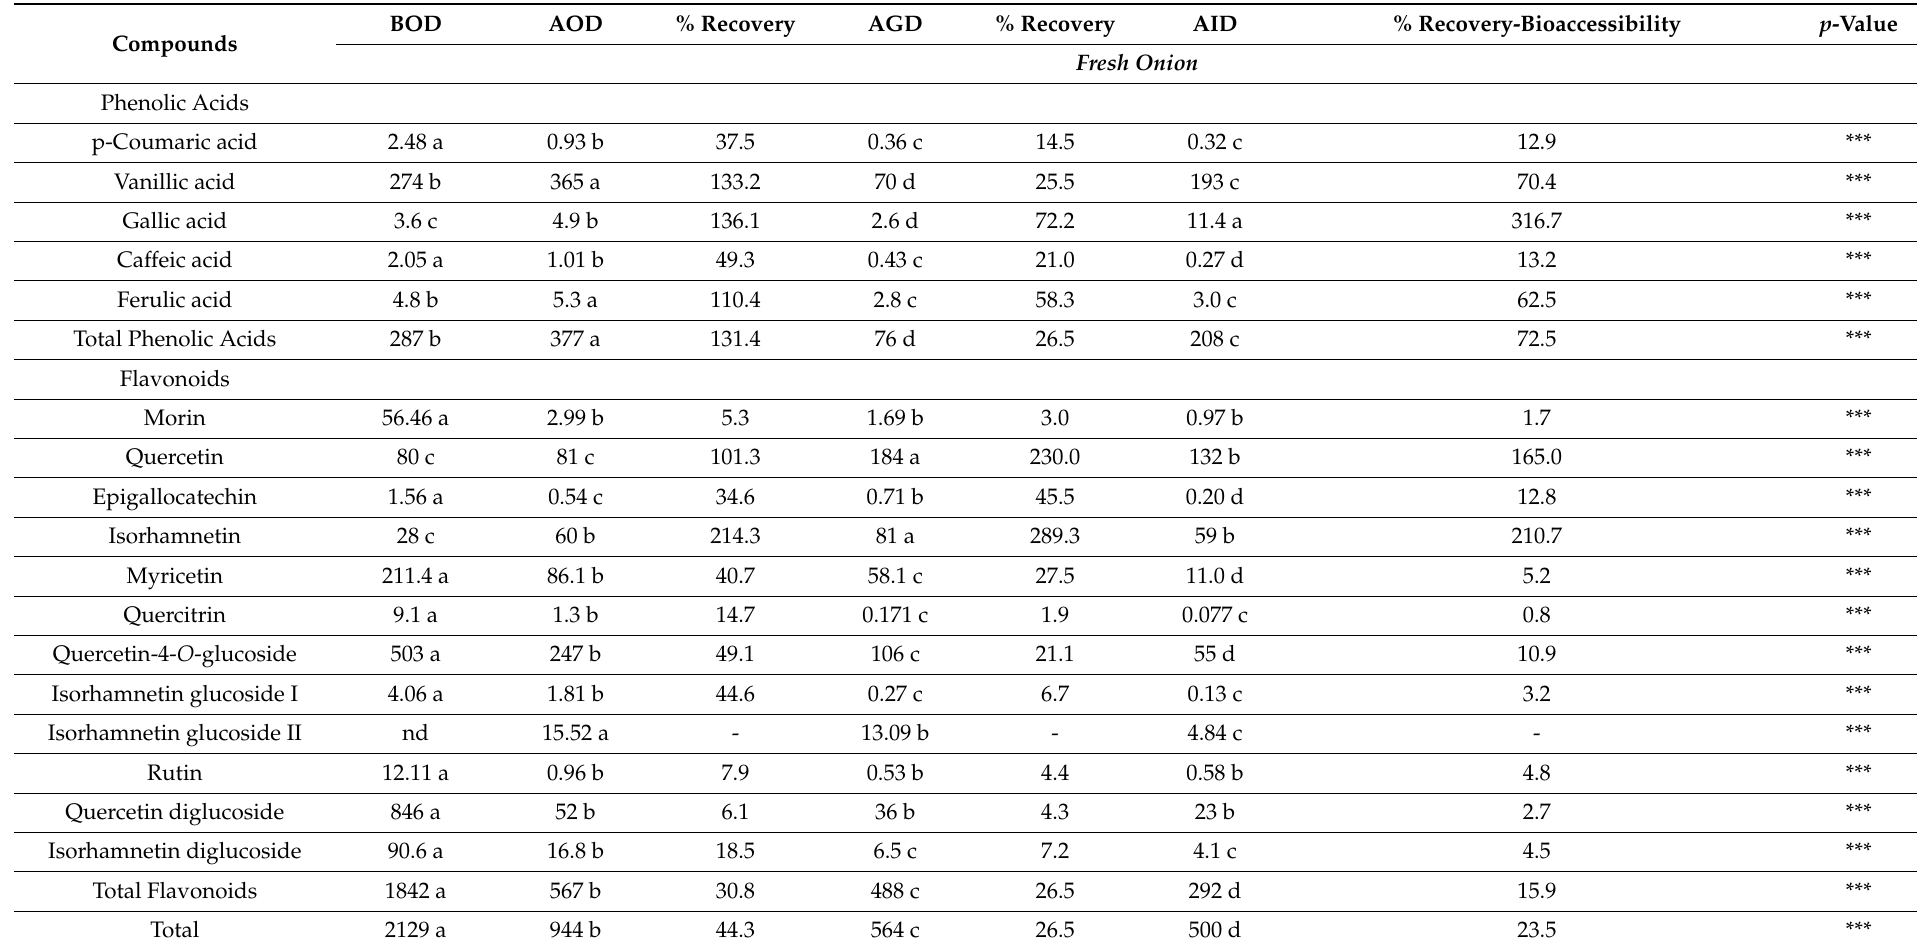
Table 2. Concentration (nmol/g FW) of polyphenols found in fresh and black onion samples at different stages of simulated gastrointestinal digestion. Data are expressed as mean values ( n =